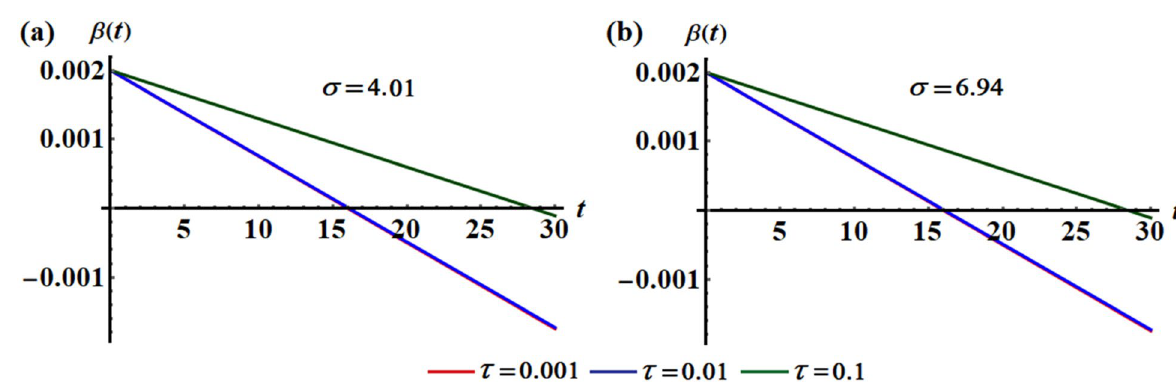
Figure 11. Shows the temporaly histories of β when L = 0.7 and τ( = 0.001, 0.01, 0.1 ) at: ( a ) σ = 4.01 , ( b ) σ = 6.94